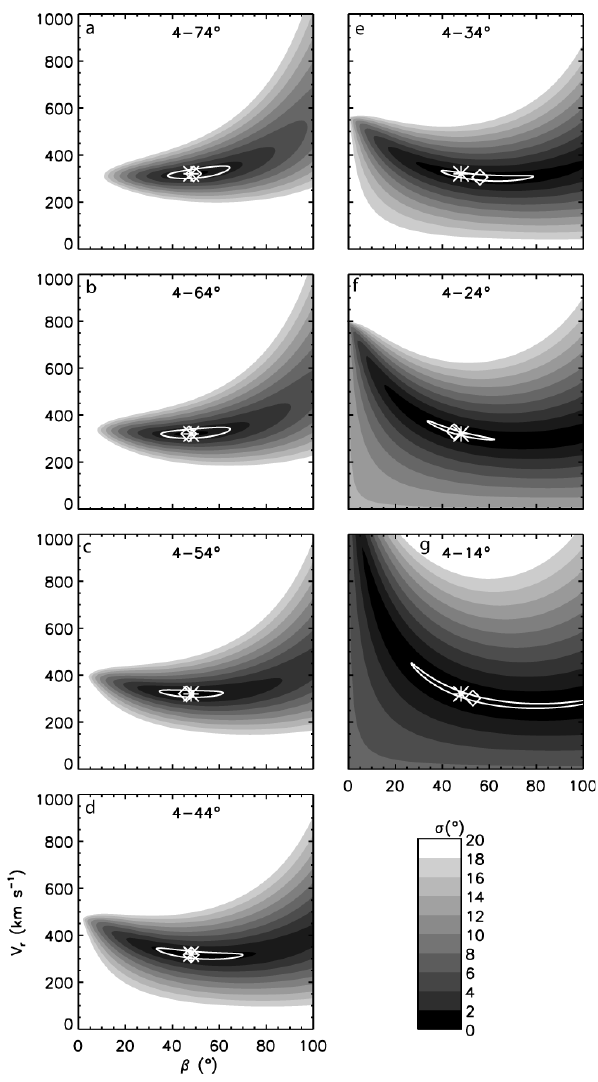
Fig. 5. Contour plots of the fit errors obtained when fitting de- creasing extents of the elongation variation corresponding to a track defined by V r =320kms − 1 and β =48 ◦ onto which a random error has been added as described in the text. In each panel the Asterisk marks the input values, and the diamond marks the best fit values. Each panel corresponds to the elongation range given. The white line marks a contour equal to twice the minimum fit